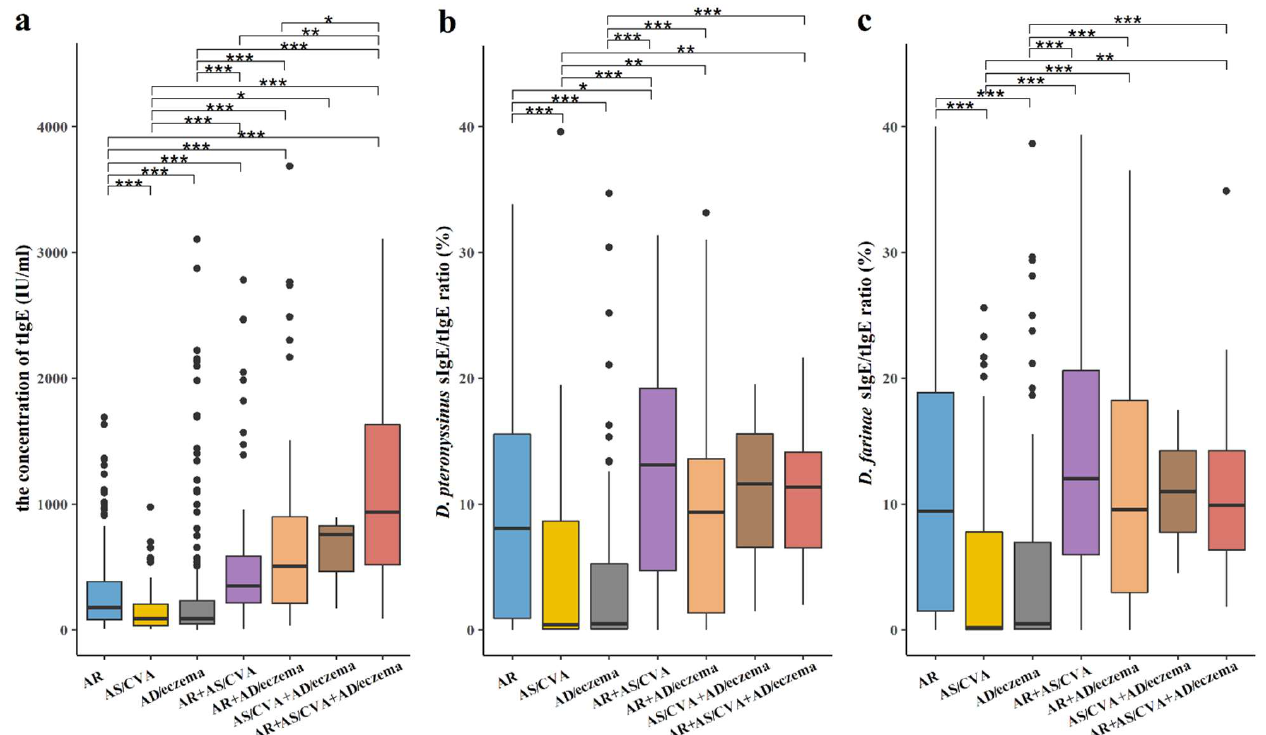
Figure 3. Serum concentration of tIgE and mite sIgE/tIgE ratio in patients with AR, AS, AD, and their multimorbidities. ( a ) Serum concentration of tIgE in patients with AR+AS/CVA+AD/eczema was higher than AR+AS/CVA; Serum concentrations of tIgE of AR or AS/CVA were lower than their multimorbidities; Serum concentration of tIgE of AD/eczema was lower than AR and AR multimorbidities, and AR higher than AS/CVA. ( b ) D. pteronyssinus sIgE/tIgE ratio was higher in patients with upper airway allergic multimorbidities, such as AR co-occurring with AS/CVA or AD/eczema, and lower in patients only have AS/CVA or AD/eczema. The ratio in AR was higher than in AS/CVA or AD. ( c ) D. farinae sIgE/tIgE ratio pattern was similar to D. pteronyssinus . *: p < 0.05; **: p < 0.01; ***: p < 0.001.